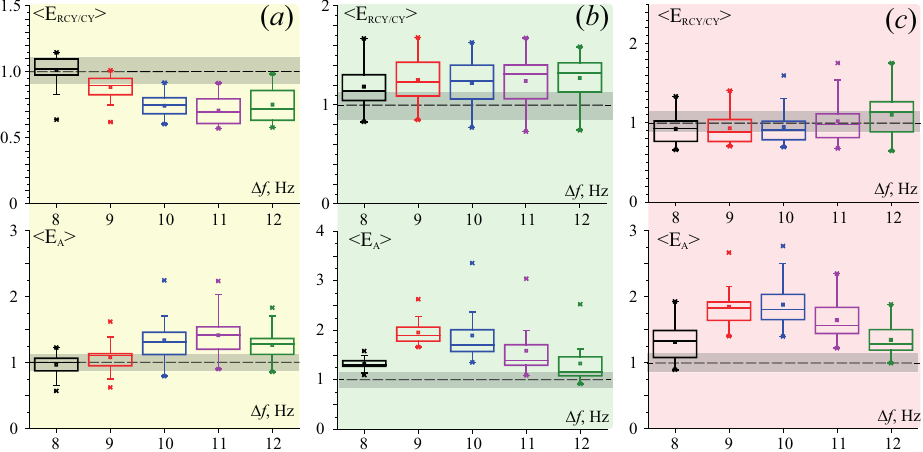
Figure 3. ( a – c ) The diagrams of energy ratio E RCY / CY (7) (top panel) and E A (8) (bottom panel) by frequency interval ∆ f ∈ ∆ f α for I, II, and III participant’s groups, respectively. The diagrams depict the following statistical characteristics of energy ratios: the first and the third quartiles (25–75%, inside the box); the median and mean (dash line and point inside the box, accordingly); 1.5 interquartile range (shown by whiskers); and outliers represented by asterisks. Light gray rectangles delineate the ranges of values representing the ratios close to